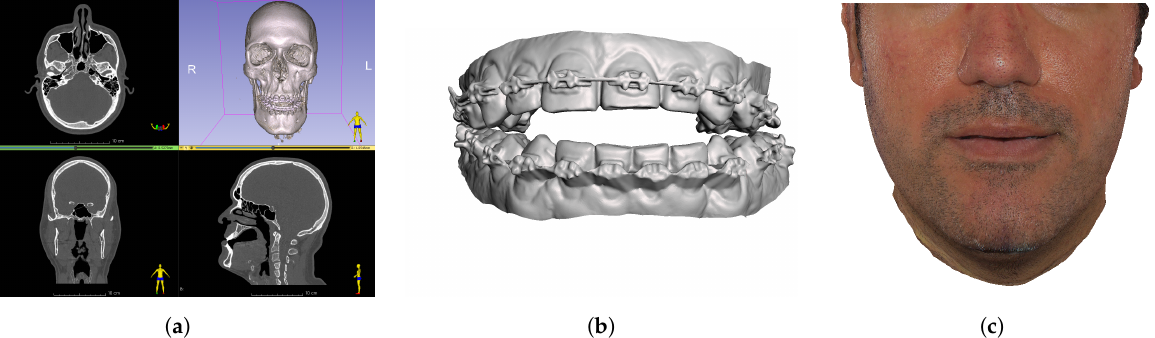
Figure 3. Summary of the patient imaging data collected for the planning process. CBCT-scan of the head ( a ), dental 3D scan ( b ), and textured face 3D scan ( c ) for patient